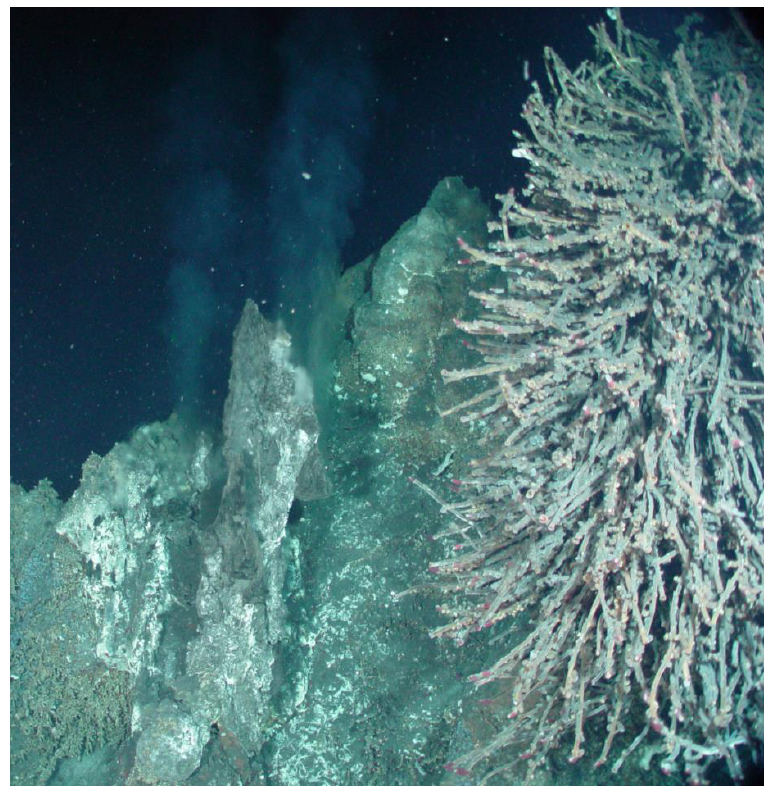
Figure 1. Photograph of deep-ocean hydrothermal vent and associated tube worms at the Juan de Fuca Ridge Vent Field in the Pacific Ocean. (Archives of V. Yurkov laboratory. Used with permission).